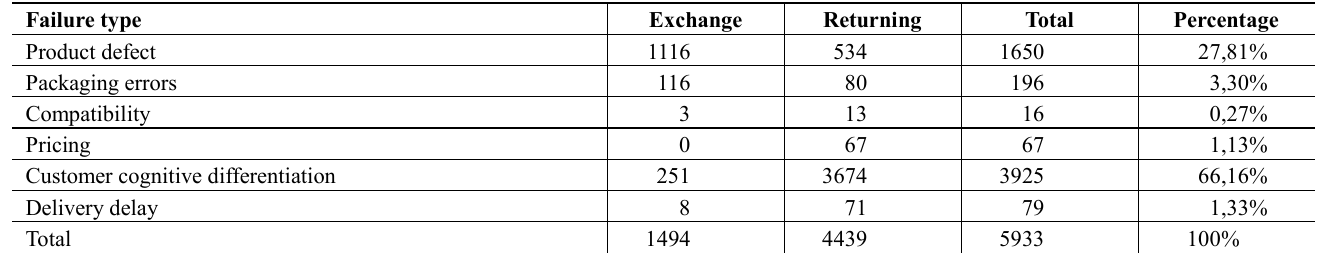
Table 2: Service failure descriptive statistics